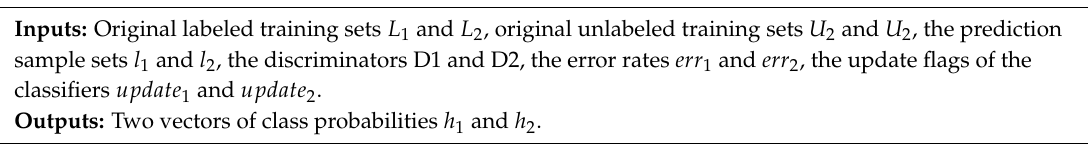
Algorithm 1. Semi-supervised learning based on multi-output DCGANs.